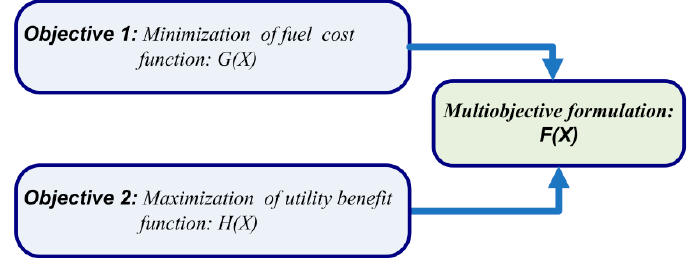
Figure 5. Formulation of multi-objective function F ( X ).